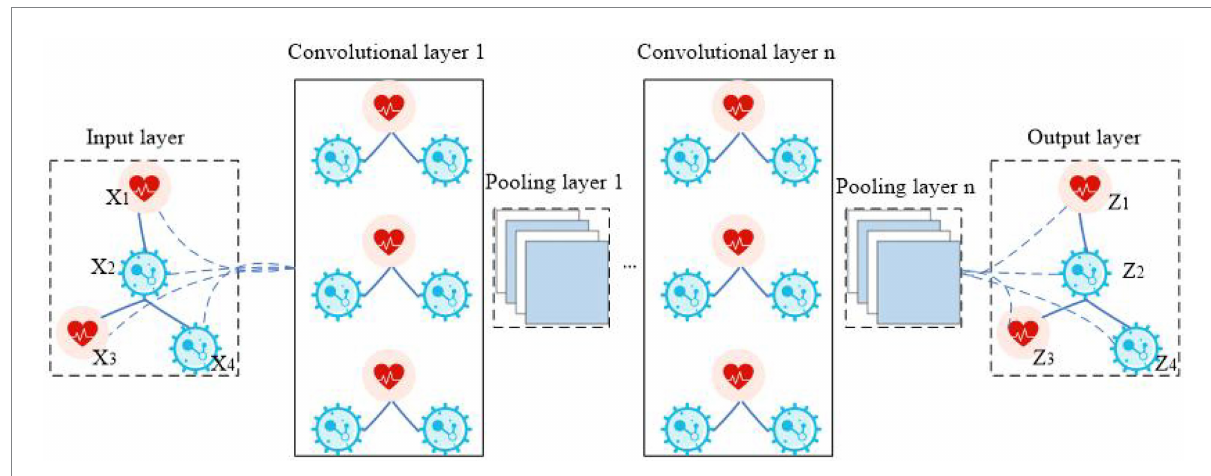
FIGURE 2 The flowchart of